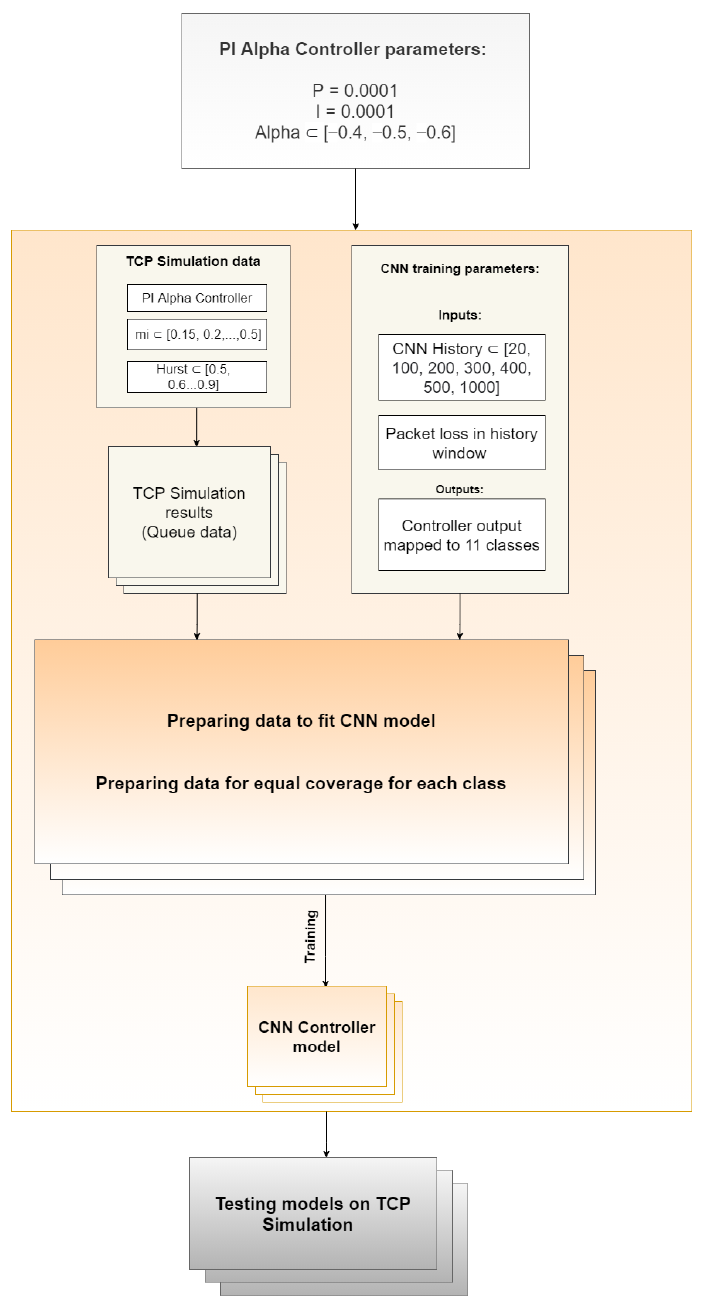
Figure 2. Training data preprocessing